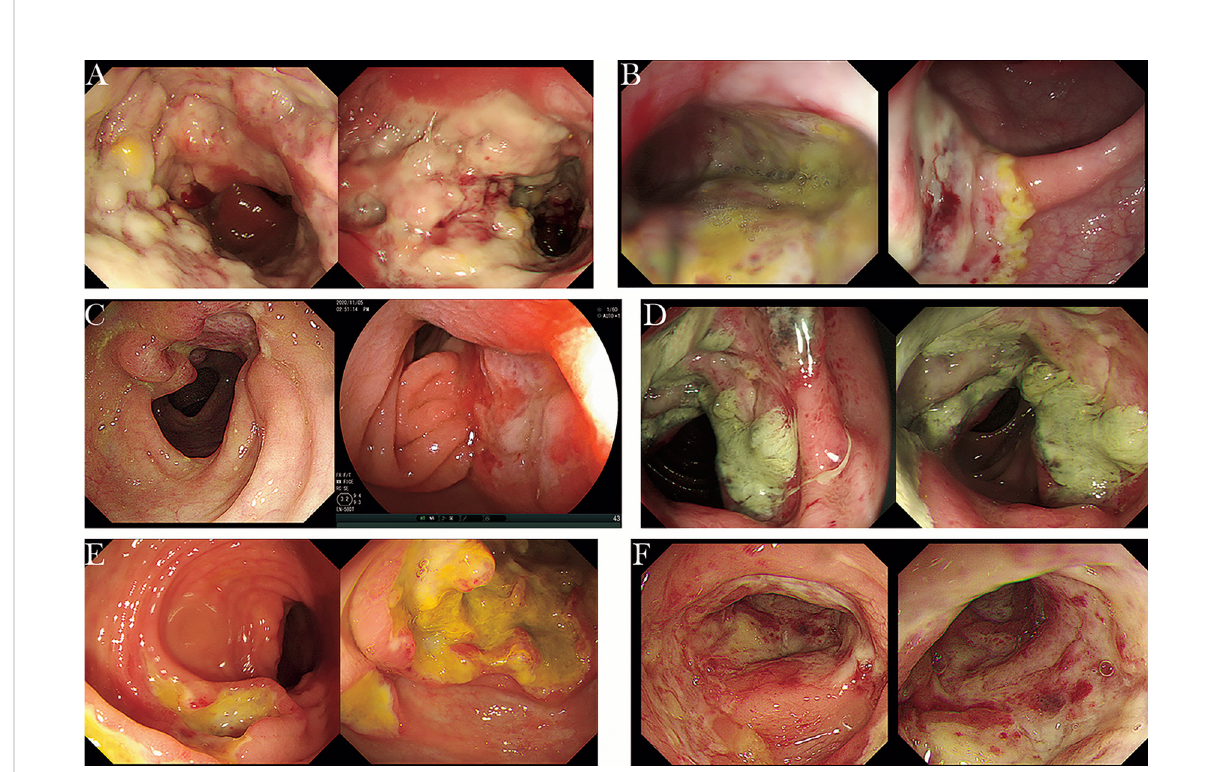
FIGURE 2 The endoscopic manifestations of intestinal NKTCL (cases from Renji Hospital Af fi liated to Shanghai Jiaotong University School of Medicine). (A) Extensive and irregular ulcers in the sigmoid colon, accompanied by mucosal hyperplasia and covered with yellow and white adhesive material. (B) Multiple large, irregular ulcers covered with white adhesive material in the transverse colon and sigmoid colon. (C) A large bulging lesion involving one half of the lumen with a sunken ulcer in the center covered with pus in the ileum and large ulcerative foci in the colon (30 cm from the anus). (D) Annular mucosal proliferative lesion with mucosal hyperemia and edema in the transverse colon. (E) Circumferential large proliferative lesion in the ileocecum and numerous circular ulcers in the transverse colon. (F) Multiple, irregular ulcers with rigid, narrow and congestive lumen in the sigmoid